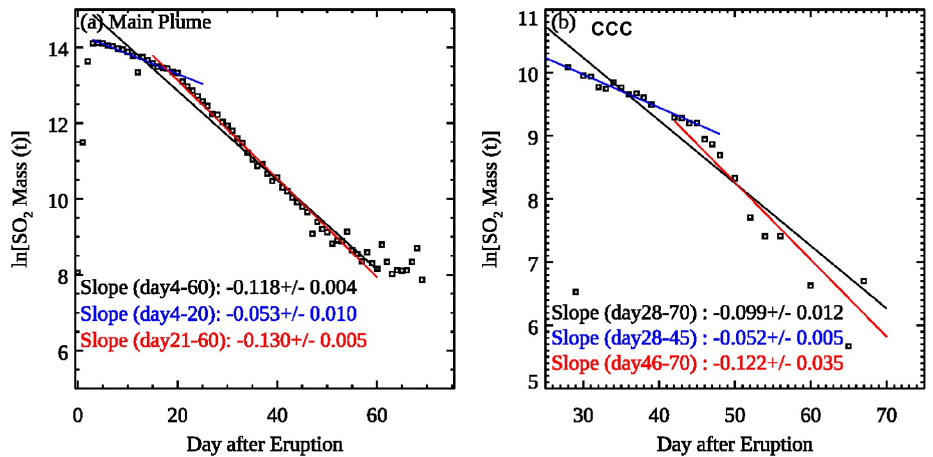
Figure 7. Time series of the logarithm of the estimated total SO 2 mass (in metric tons) within (a) the main plume (45–85 ◦ N) and (b) the